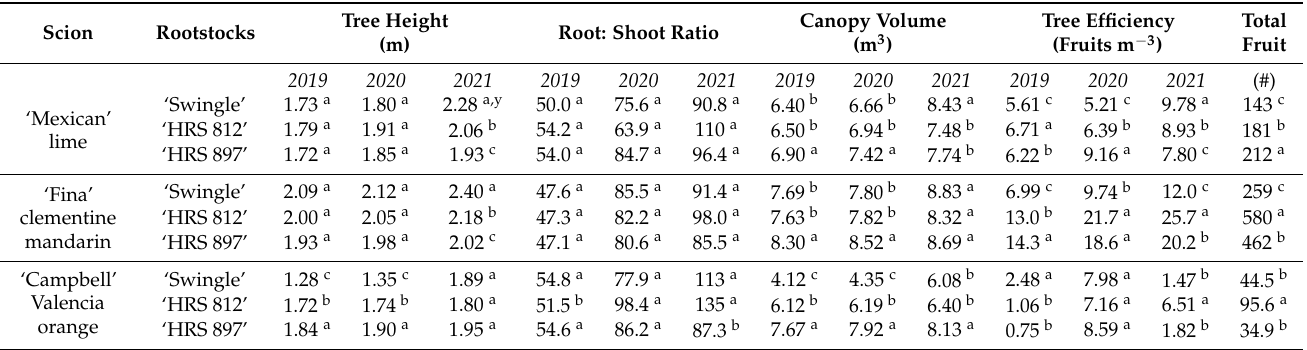
Table 4. Tree height, root-to-shoot ratio, canopy volume, efficiency, and total yield (2018–2021) of three citrus cultivars grafted in three different rootstocks growing on Coto soil series at the Agricultural Experiment Substation of Isabela, Puerto Rico in